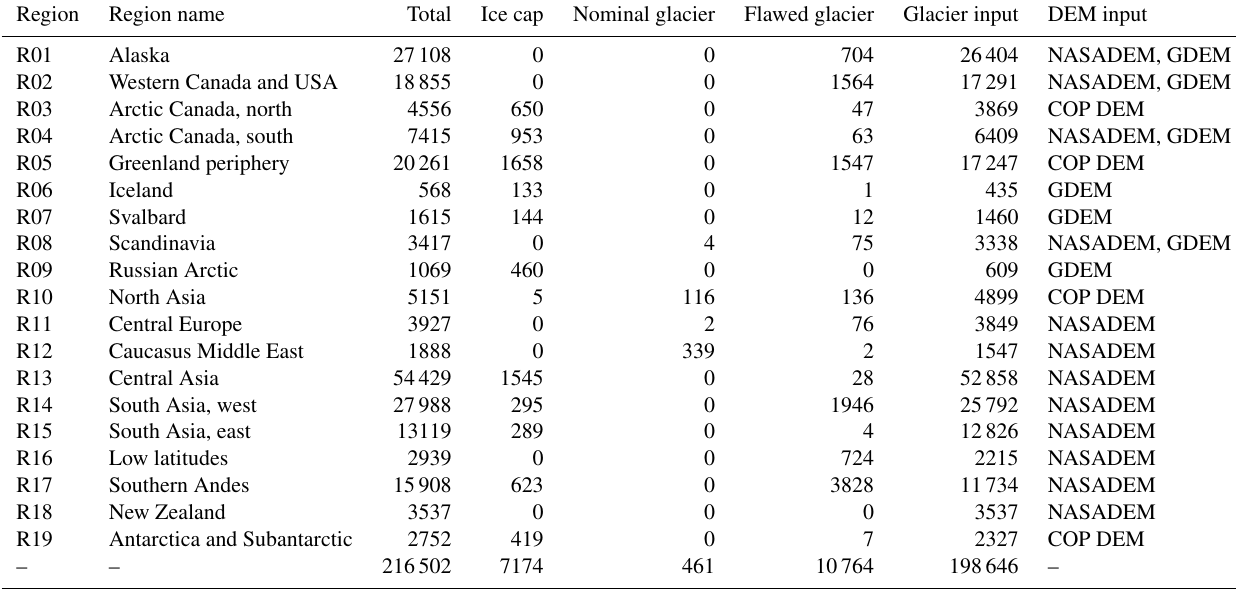
Table 2. Pre-processing results of different glacier regions and information of input datasets.